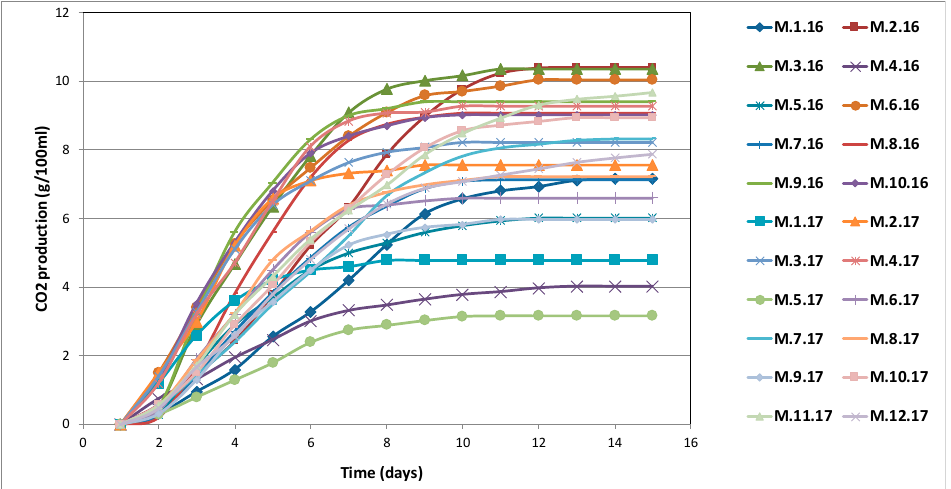
Figure 6. Carbon dioxide production by the 22 Lebanese S. cerevisiae isolates during alcoholic fermentation in synthetic grape juice (SGJ).